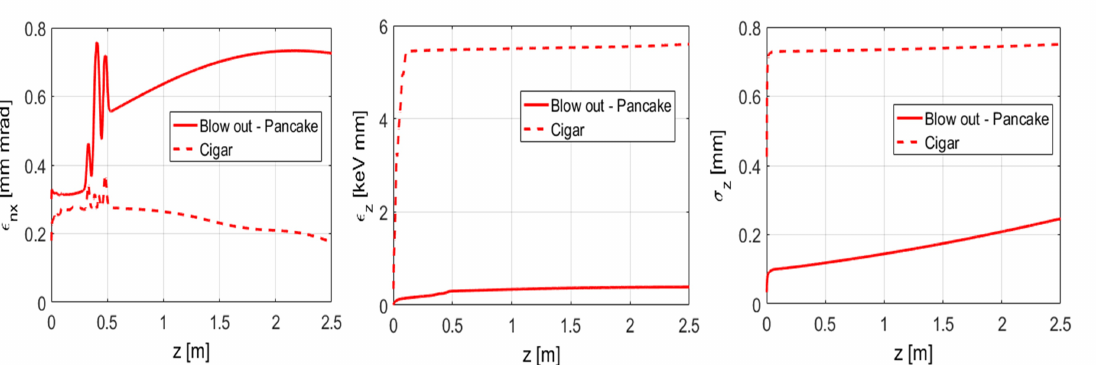
Figure 11. Evolution of transverse emittance, longitudinal emittance and bunch length from the cathode to the linac entrance for the working-points represented in Figure 10. Table 4. Laser and RF gun parameters used for obtaining the beam distributions shown in Figures 10 and 11. All the working points presented are obtained for a bunch charge of 20 pC. In the last column, the transverse and longitudinal shaping of the laser profile are specified. The following abbreviations are used: FT = Flat-Top, Gauss = Gaussian. WP E gun [MV/m] Laser RMS Spot [mm] Laser RMS Length [ps] Laser Trans/Long Shape Cigar 110 0.088 FT/Gauss Blow out